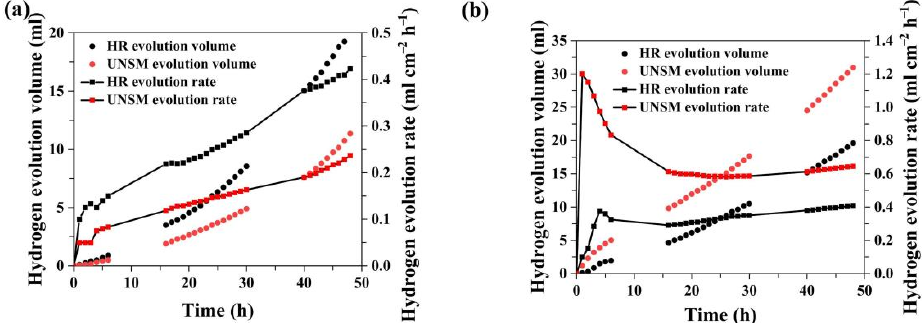
Figure 13. Variation in the hydrogen evolution volumes and rates of LAE361 Mg-Li alloy ( a ) and LA106 Mg-Li alloy ( b ) with time.